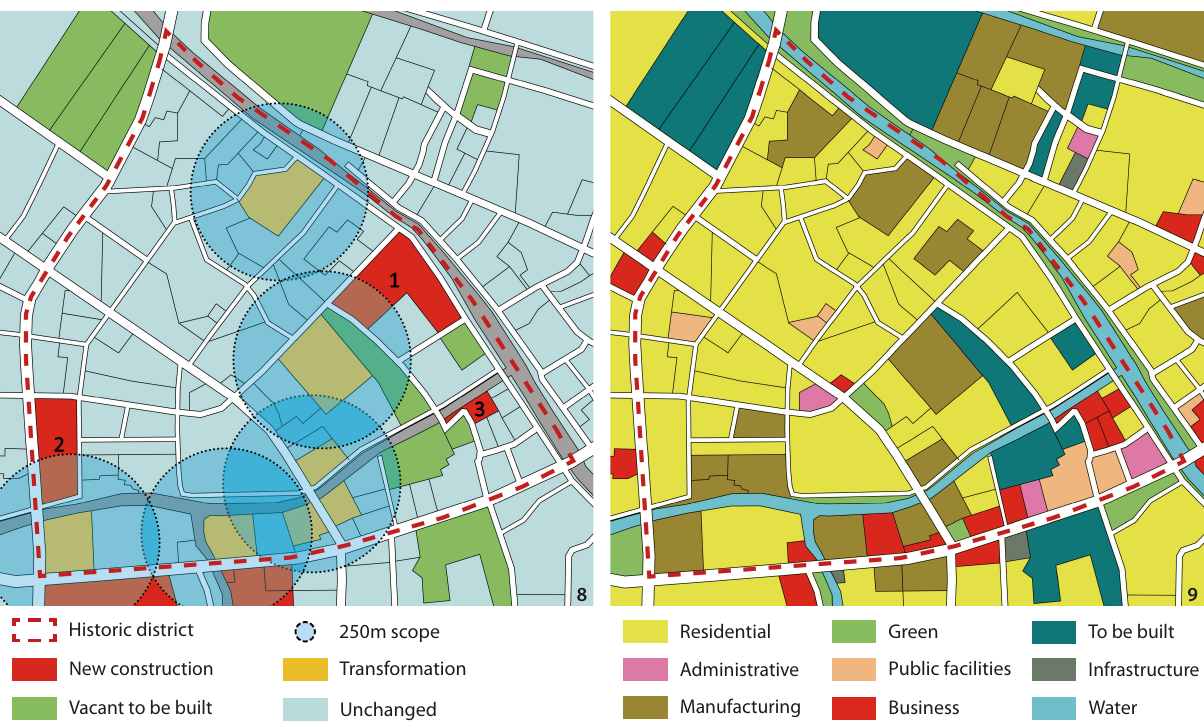
Figure 8 New, transformation and land to be built in Sanbao Street District (2009–2018) (Source: the author). Figure 9 Current land use situation in Sanbao Street District (2018. 08) (Source: